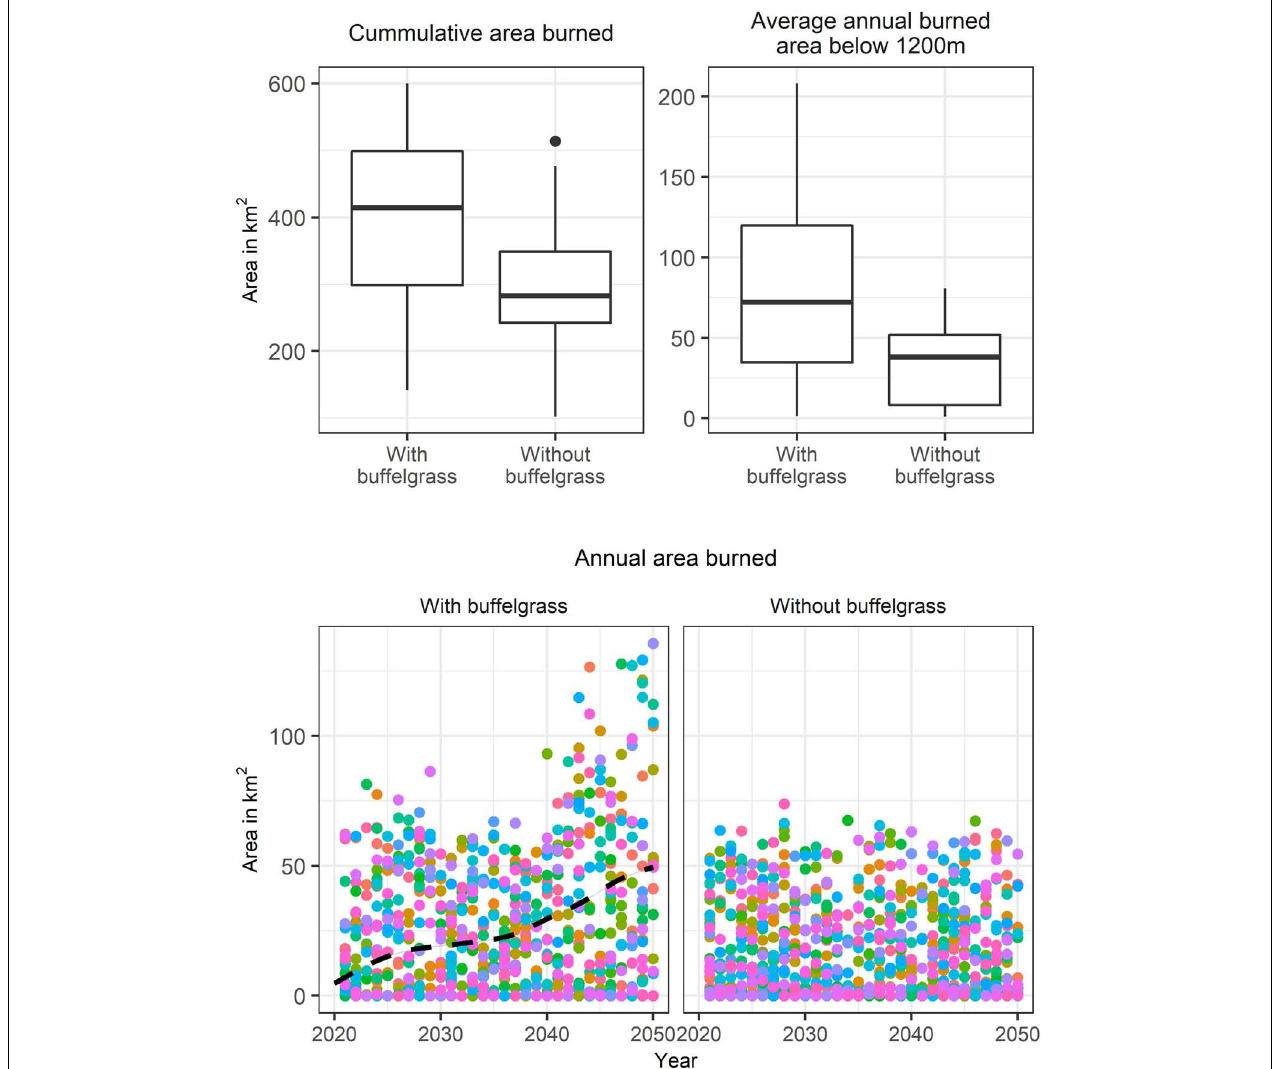
FIGURE 10 | State-and-transition fire-spread models. Box plots and time series of 50 Monte Carlo simulations across a 30-year time horizon simulating fire for two scenarios, with and without buffelgrass spreading across the landscape. Box plots include average annual burned area below 1,200 masl and cumulative burned area over the 30-year period. Time series (bottom panels) are annual area burned colored by different Monte Carlo simulations for each simulation year for the two scenarios with the black line representing the average annual area invaded by buffelgrass over the course of the